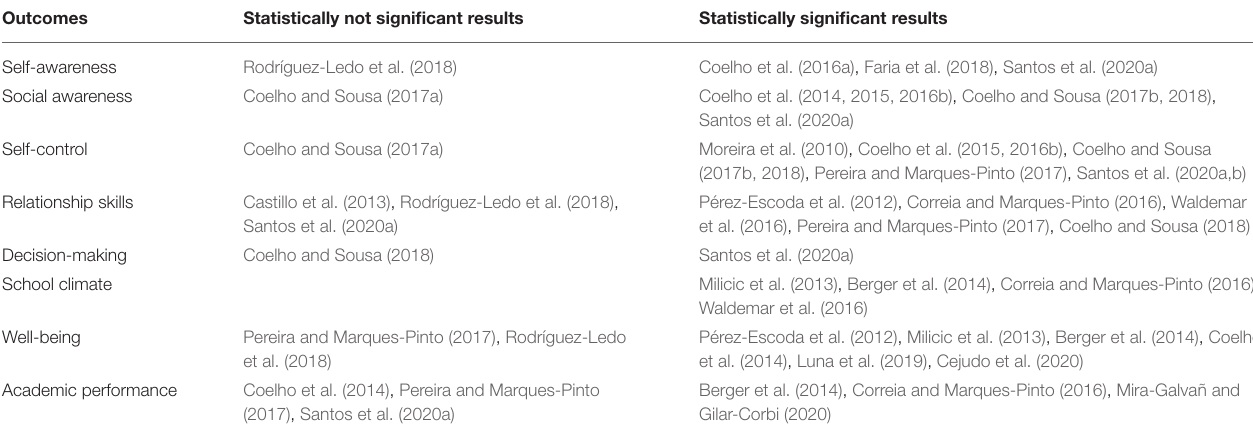
TABLE 2 | Study results for each dependent variable of the SEL model.